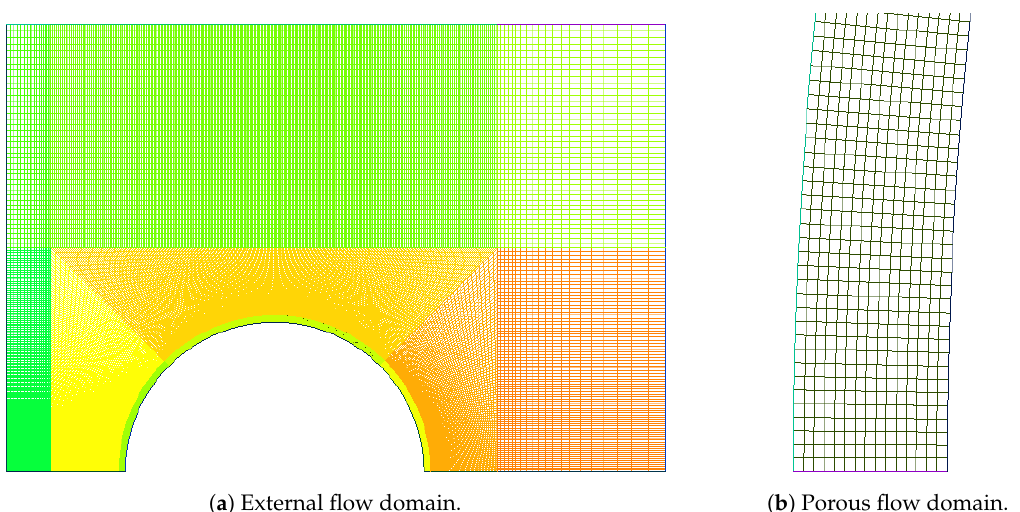
Figure 3. Geometric details (not to scale).